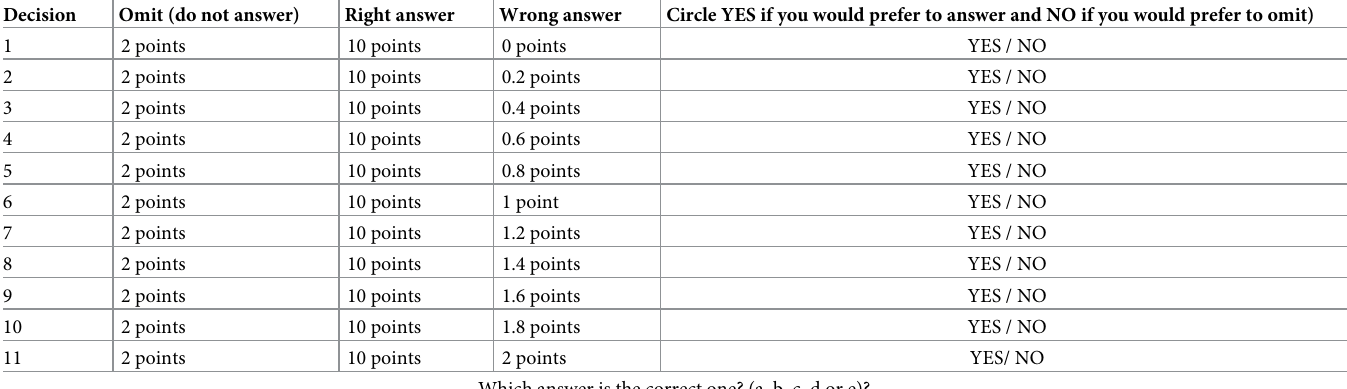
Table 4. Exam treatment, Ex . Question: When was prospect theory first introduced by Kahneman and Tversky? a) 1980 b) 1979 c) 1978 d) 1977 e) 1976. Decision Omit (do not